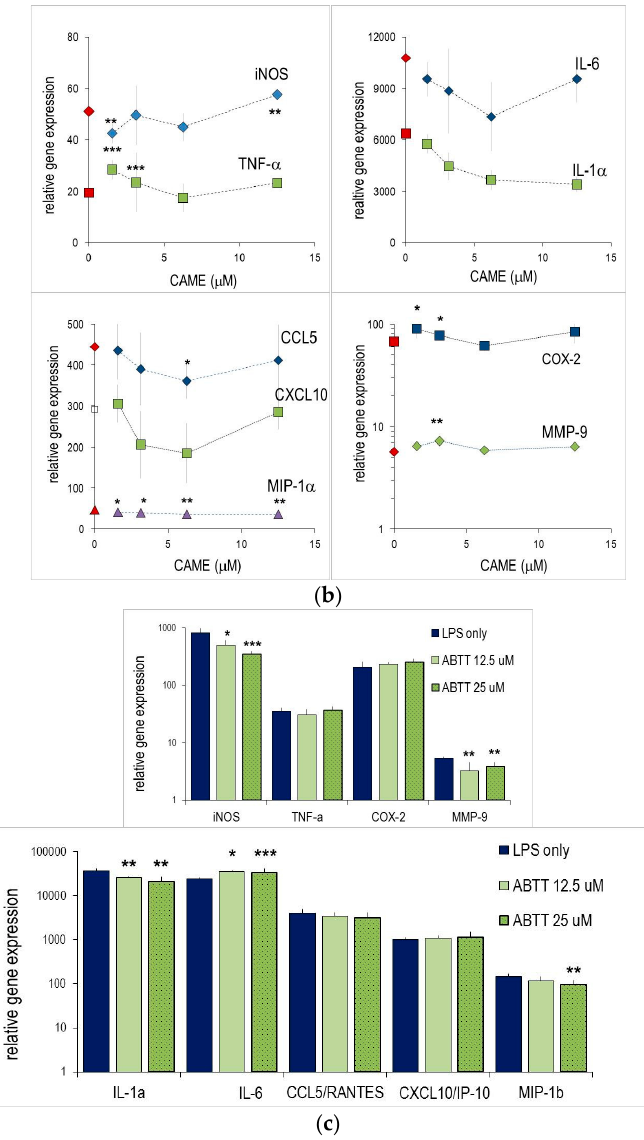
Figure 2 . Abietane diterpenes down-regulated gene expression in RAW264.7 cells. Cells were stimulated with LPS in the presence of indicated amounts of substances for 4 h and the levels of mRNA determined by quantitative RT-PCR. “Relative gene expression”, which indicates gene expression levels in stimulated relative to unstimulated cells, was calculated as described in Materials and Methods. Asterisks indicate statistical significant differences compared to LPS-stimulated cells (* p < 0.05, ** p < 0.01, *** p < 0.001; n = 3). Effect of carnosol ( a ); carnosic acid 12-methylether (CAME) ( b ) and abieta-8,11,13-triene-11,12,20 triol (ABTT) ( c ).